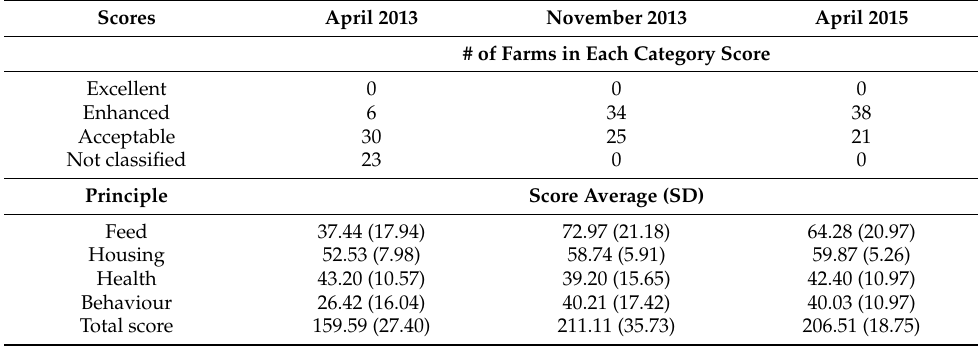
Table 6. Scores with the new Welfare Monitor of the farms in the years 2013 and 2015.